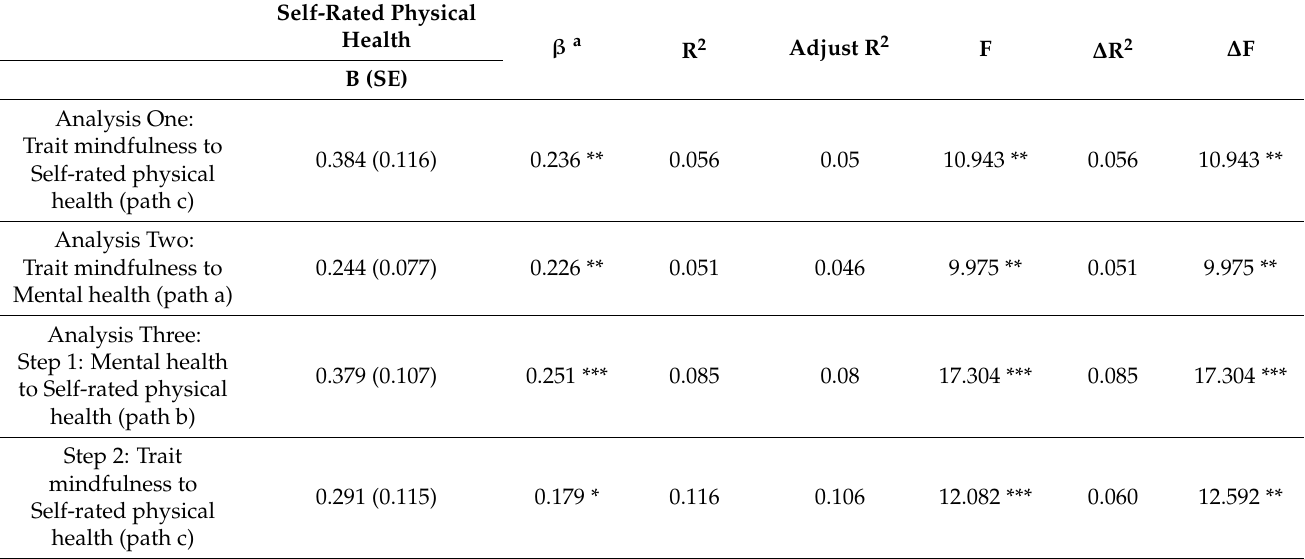
Table 2. Results of hierarchical regression analysis of the self-rated physical health model.